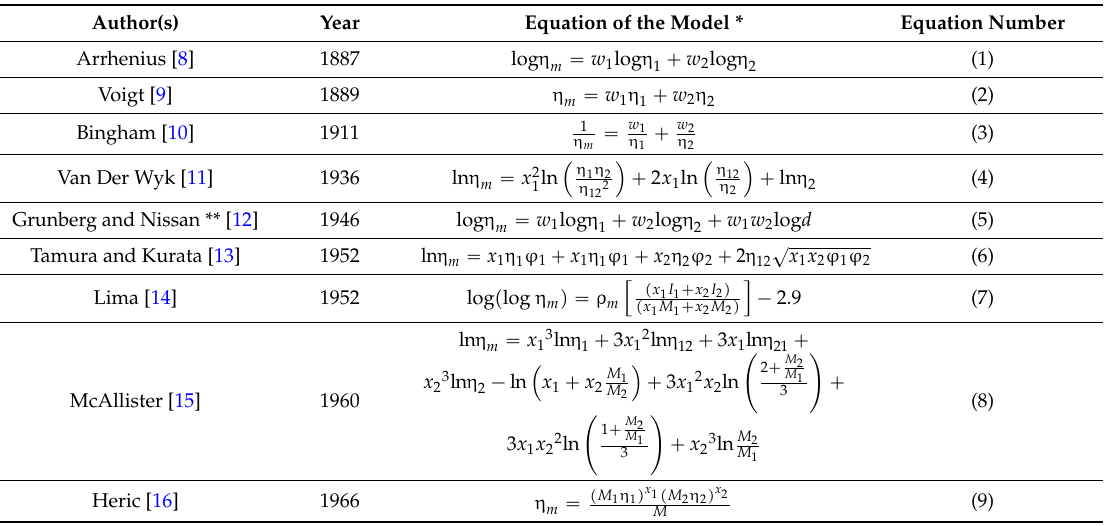
Table 1. Selected viscosity models for binary